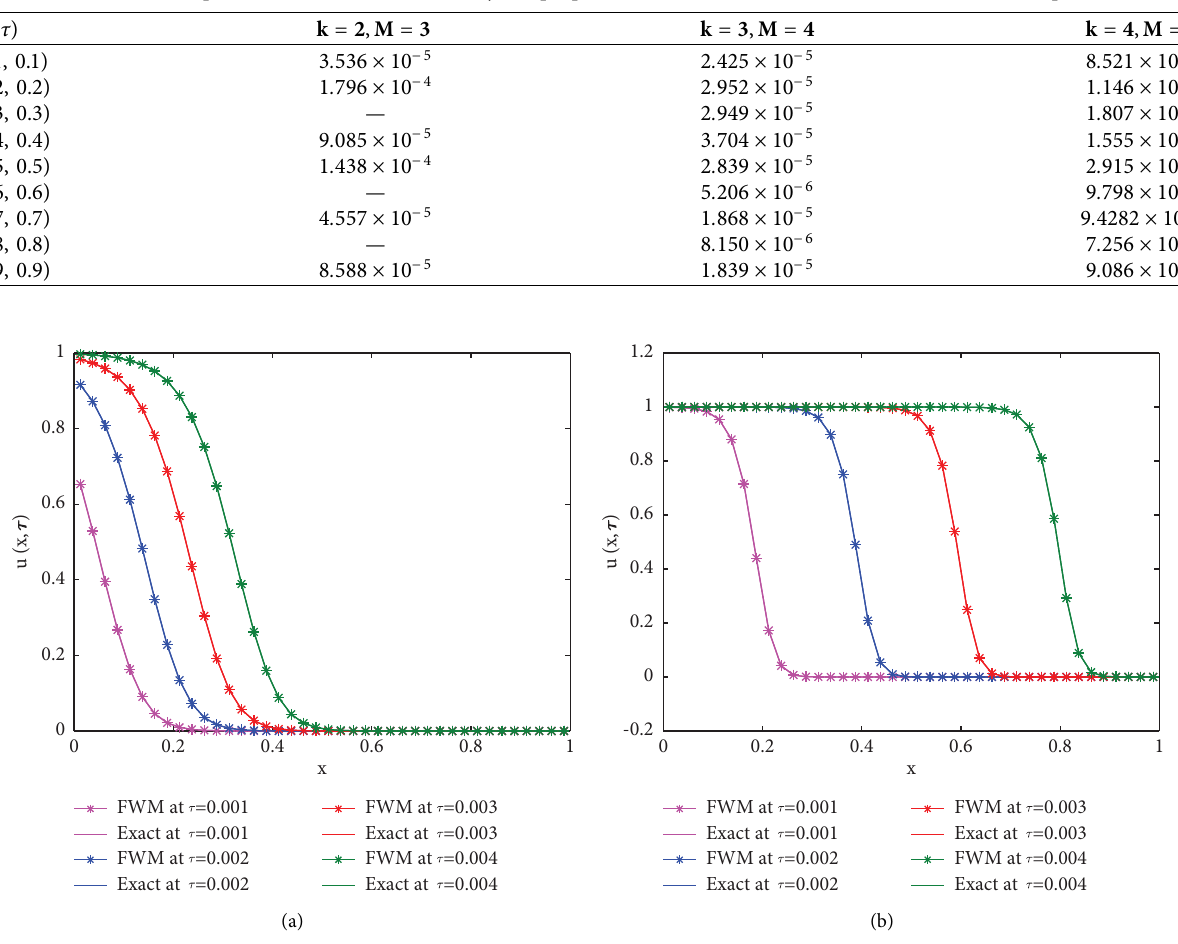
Figure 10: (a) Comparison of approximate solution and exact solution at α � 10000 of Example 4 at k � 4 ,M � 5. solution at α 2